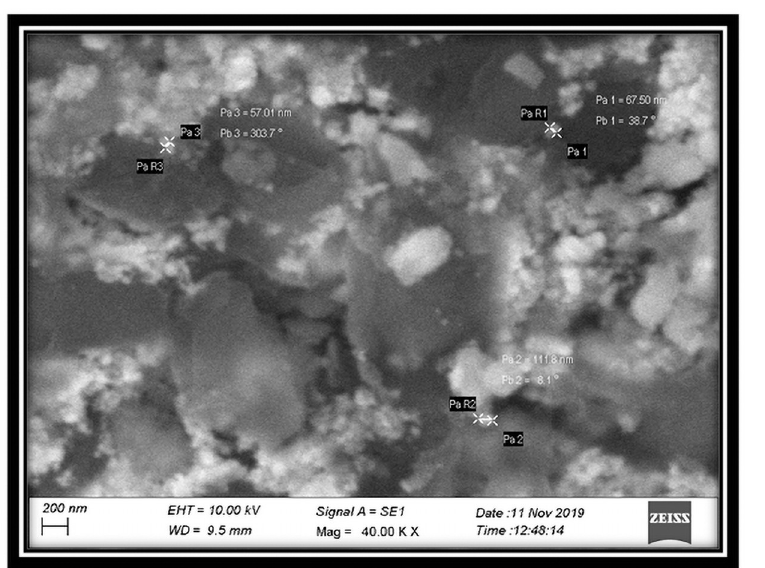
Fig 7. SEM image of silver nanoparticles of nano size averaging 78.77 nm.